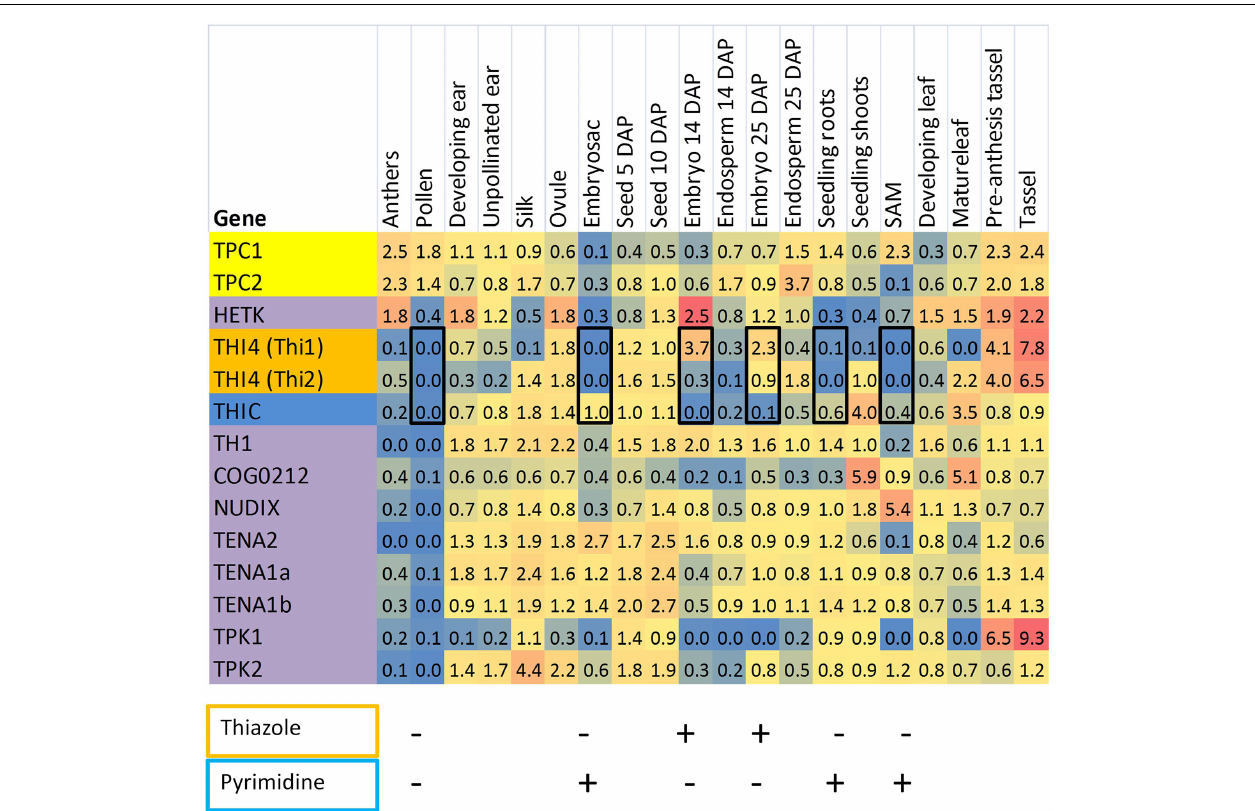
FIGURE 4 | Distribution of thiamin biosynthetic capacities of maize tissues inferred by transcriptomics. A heat map was constructed from transcriptome datasets compiled at QTELLER.org by normalizing FPKM values to the mean for each gene across all tissues. Shades of red indicate high expression relative to the mean and blue shading denotes low relative expression. On the left panel, genes encoding thiazole biosynthesis functions are highlighted gold, and the pyrimidine synthetic gene (THIC) is colored blue.